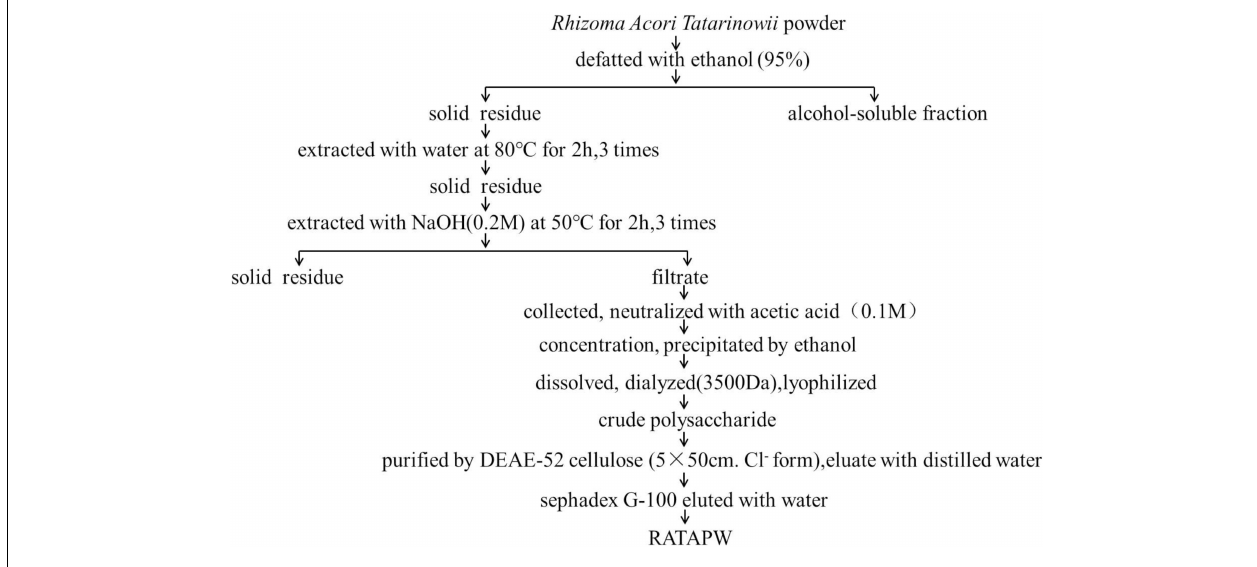
FIGURE 1 | Flowchart of purification polysaccharide RATAPW from Rhizoma Acori Tatarinowii.